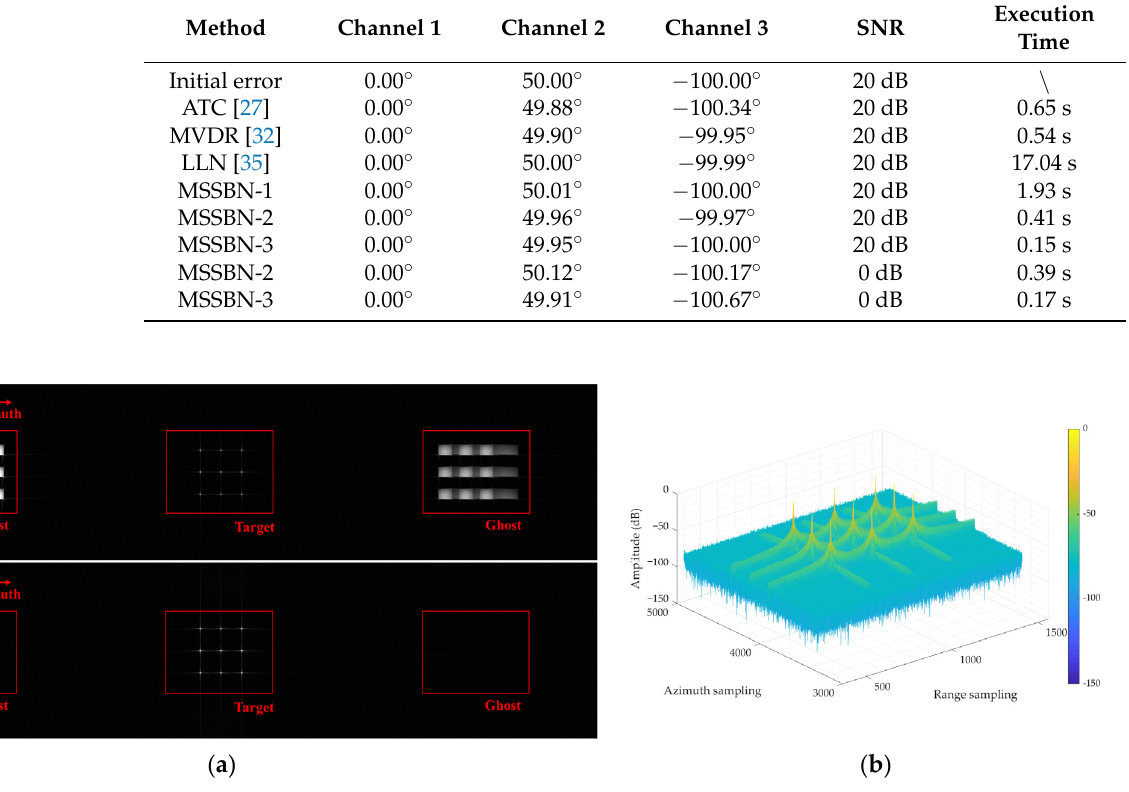
Figure 8. Imaging results after phase error calibration. ( a ) Phase errors introduce false targets, and ambiguity is suppressed when phase errors are calibrated. ( b ) Ambiguity suppression effect for point targets.